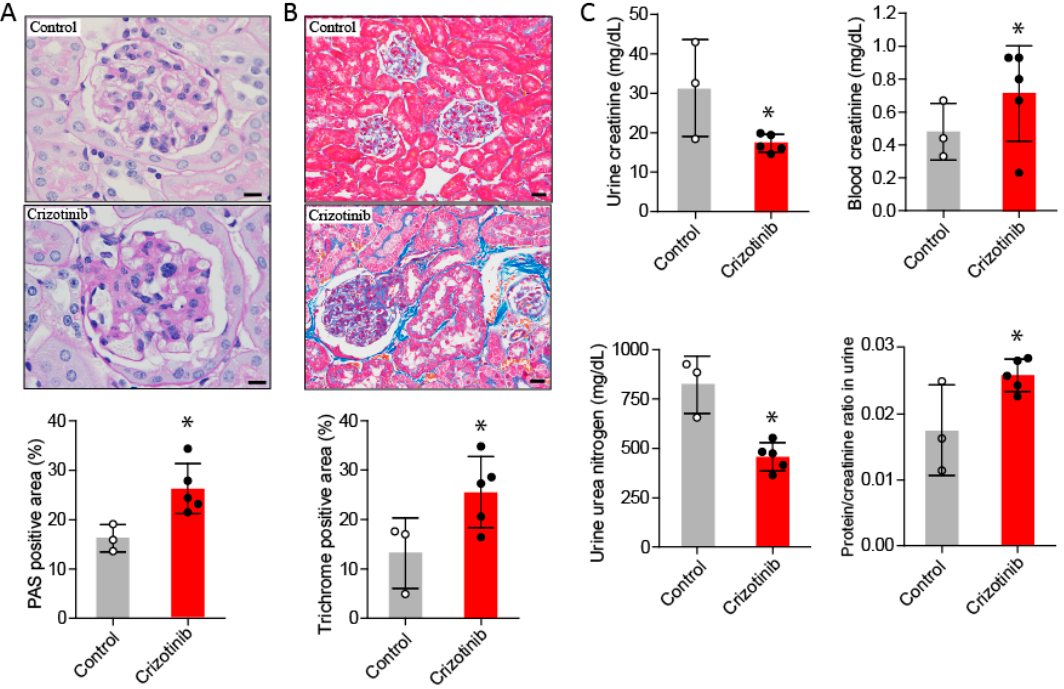
Figure 3. Renal fibrosis and increased markers of renal failure after crizotinib administration. Periodic acid-Schiff staining shows glomerular mesangial expansion in mice treated with crizotinib compared to untreated mice ( A ), scale bar indicates 10 µm. Masson’s trichrome staining shows increased glomerular and interstitial fibrosis in the kidneys from mice treated with crizotinib compared to those from untreated mice ( B ), scale bar indicates 20 µm. The blood level of creatinine, urine levels of urea nitrogen and creatinine and the ratio of total protein to creatinine in urine were significantly different between control and crizotinib groups ( C ). Data are mean ± SD. Control group n = 3; crizotinib group n = 5. * p < 0.05 versus control group.